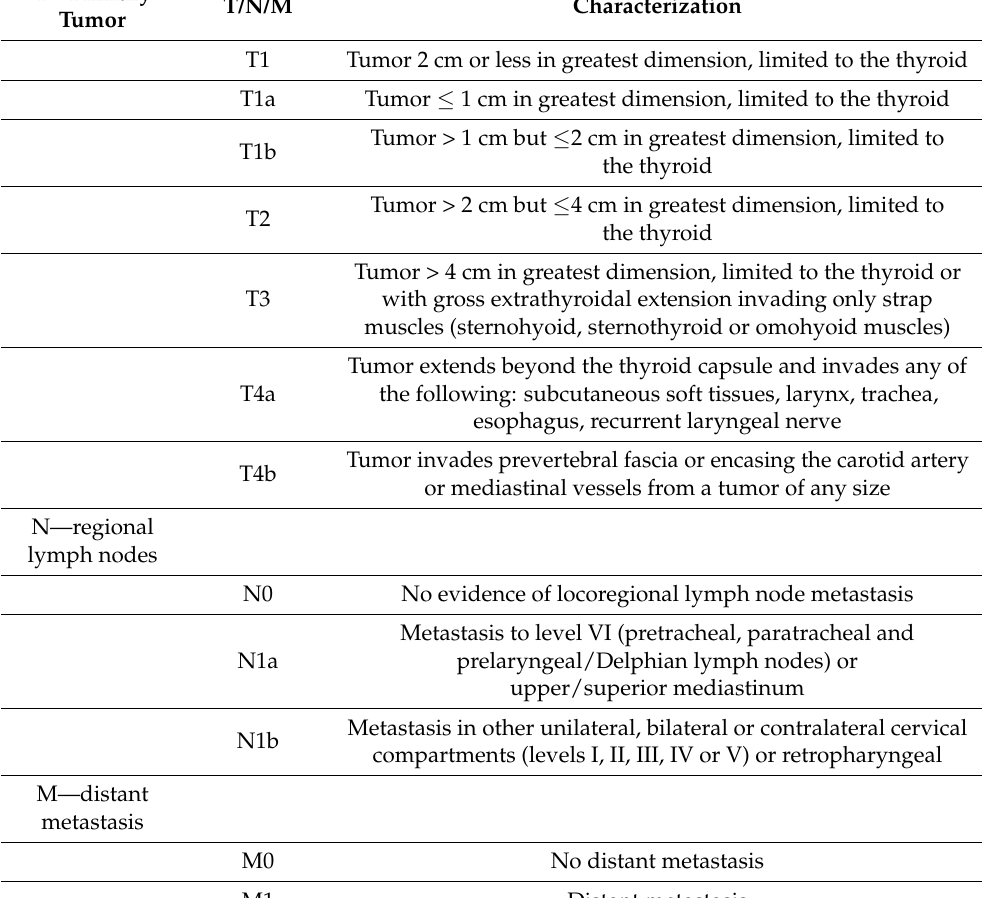
Table 1. UICC TNM